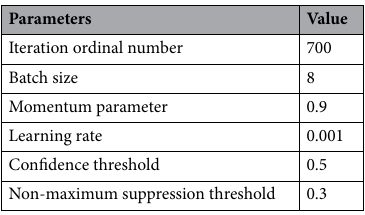
Table 2. Setting of model training parameters.